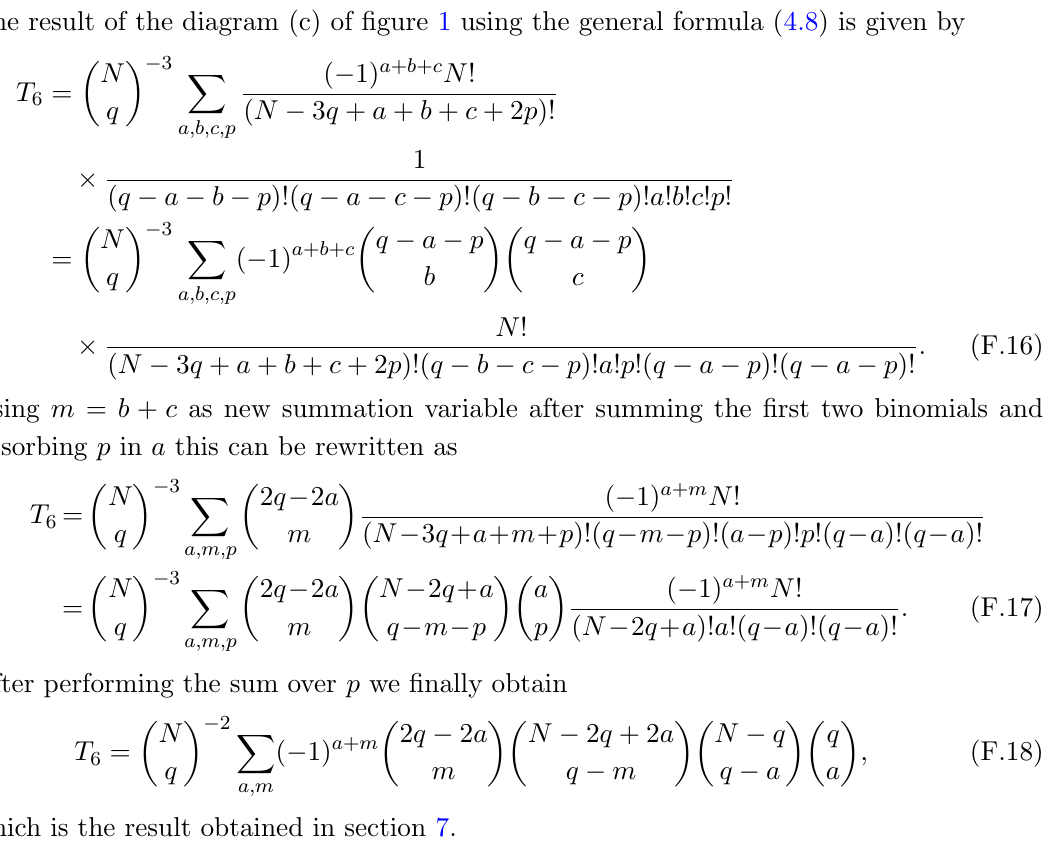
Figure 16 . The only diagram with six intersections contributing to the 8th moment. This diagram has not been encountered before and the result will be denoted by T 8